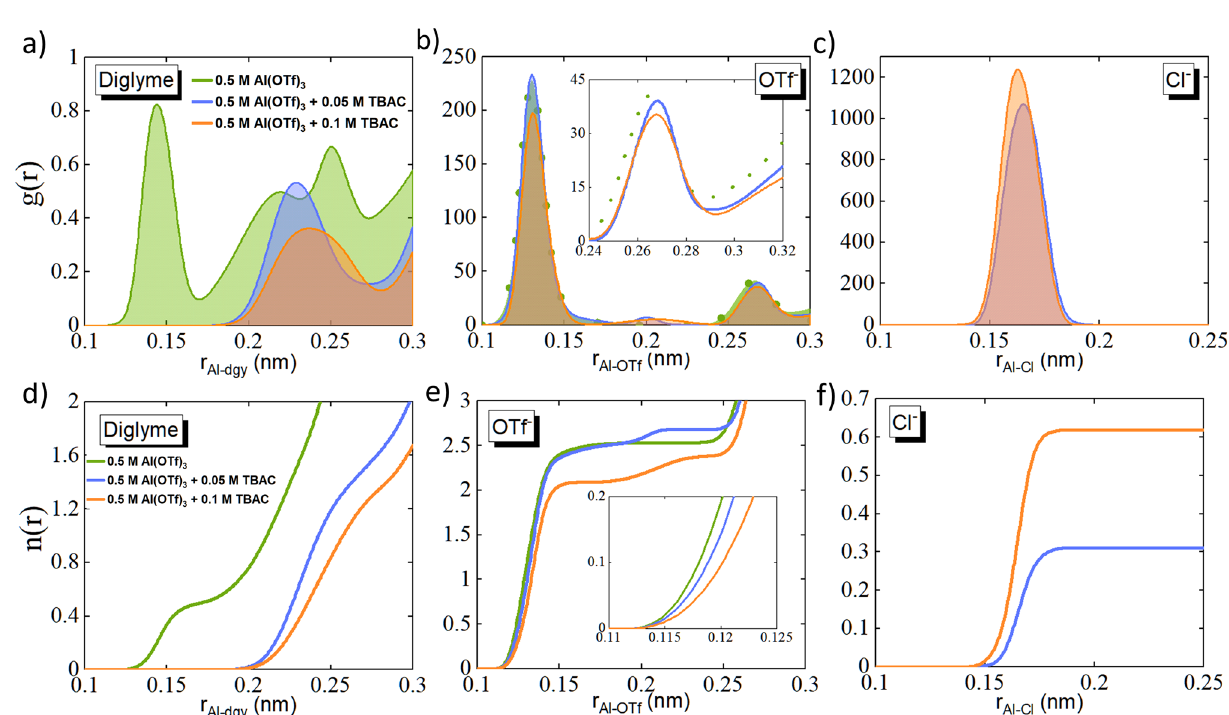
Fig. 3 Electrolyte solvation study from molecular dynamics simulations. Radial distribution function (RDF), g(r), of a diglyme, b OTf − and c Cl − as a function of radial distance (r) from Al 3+ ion for the three electrolyte systems −0.5 M Al(OTf) 3 , 0.5 M Al(OTf) 3 + 0.05 M TBAC and 0.5 M Al(OTf) 3 + 0.1 M TBAC. Running coordination number of d diglyme, e OTf − and f Cl − corresponding to ( a ), ( b ) and ( c ),